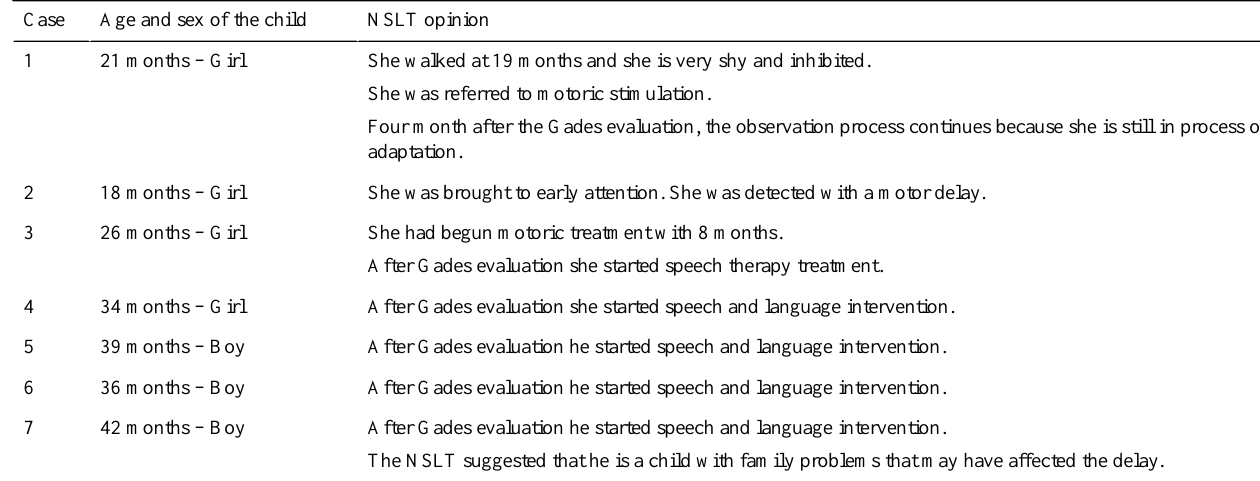
Table 3. Decision of the NSLT a on 7 new cases of children with possible language